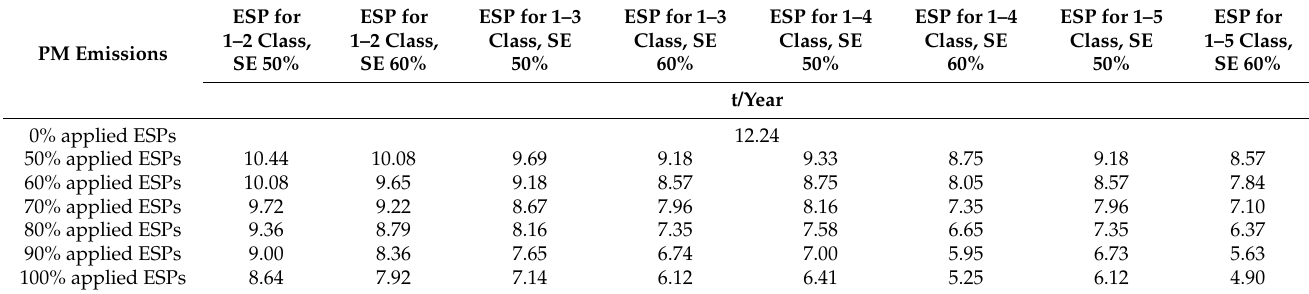
Table 2. Total PM production in the model village in more realistic